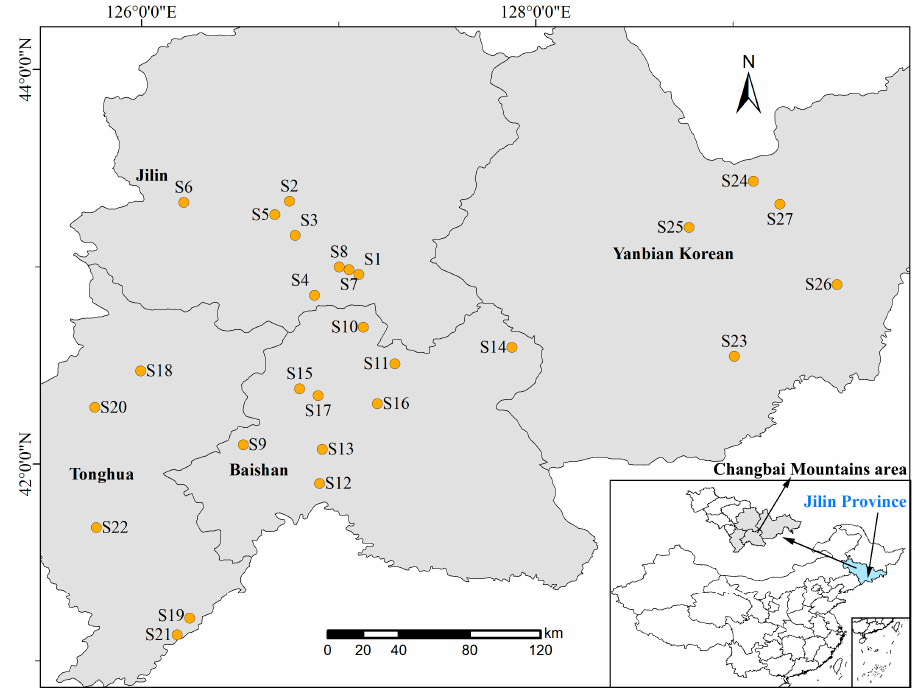
Figure 2. Regional distribution of 27 batches of Oviductus Ranae in Changbai Mountains area.